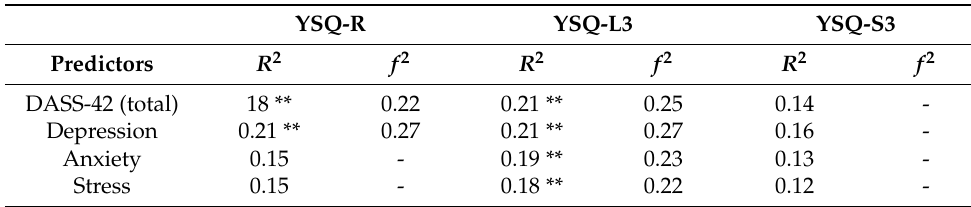
Table 5. Regression Analysis for total Pre-Treatment YSQ and Subscale Symptom Change in the Alcohol and Substance Use Group. YSQ-R YSQ-L3 YSQ-S3 Predictors R